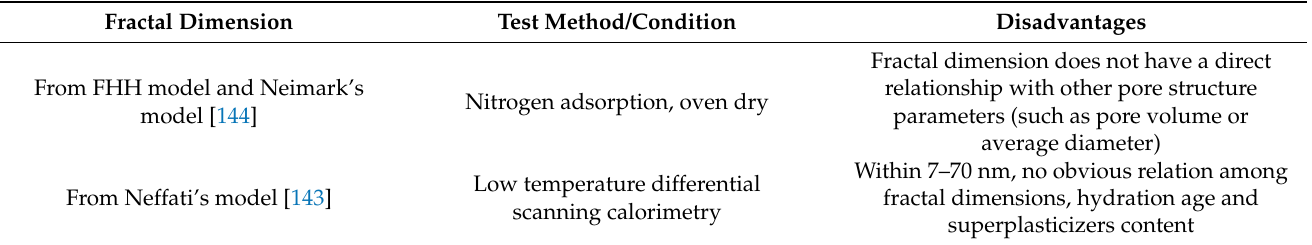
Table 4. Comparison of D s and D m of C-S-H gels from previous literature. Fractal